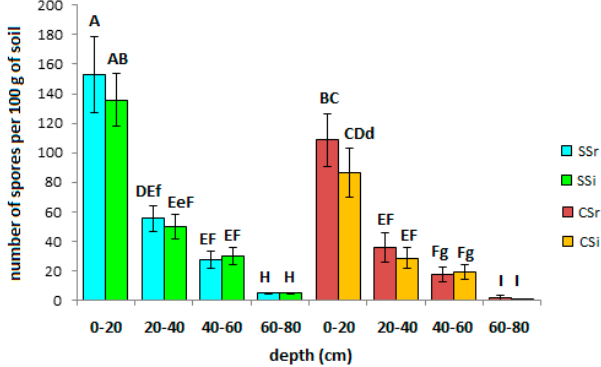
Figure 3. Spore abundance expressed as number of spores per 100 g of soil with standard deviation and Tukey HSD intervals. CSr: conventional system in the row; CSi: conventional system inter-rows; SSr: sustainable system in the row; SSr: sustainable system inter-rows. Different capital letters and lowercase indicate a statistical difference at p < 0.01 and p < 0.05 level, respectively.